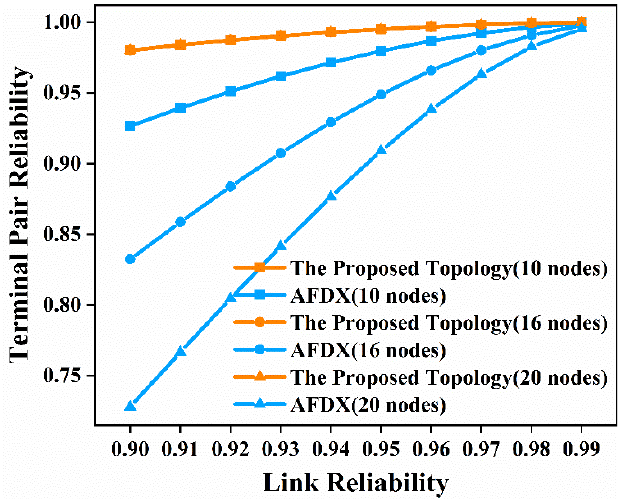
Figure 7. Time-independent terminal pair reliability comparison diagram of the proposed topology and AFDX in the three